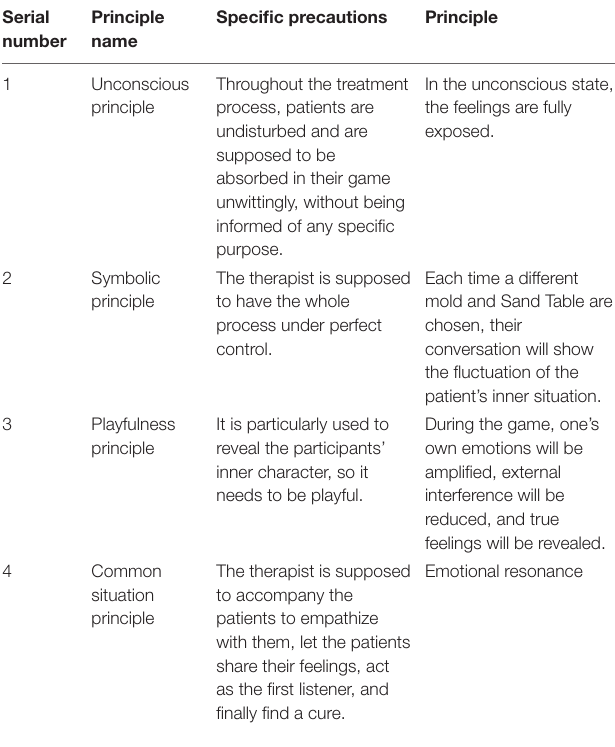
TABLE 1 | Principles for Sand Table